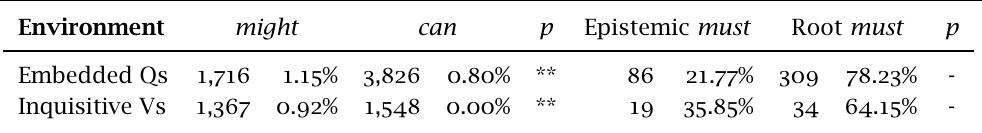
Distribution of modals in embedded questions: ** p < 0 . 001 , - p > 0 . 05 , Fisher’s exact test. For might and can , compares each environment to their respective wider distributions in the corpus. Flavors of must were compared to the distribution found in matrix contexts ( 17 %